Question: What visual encoding does this figure use to show its data?
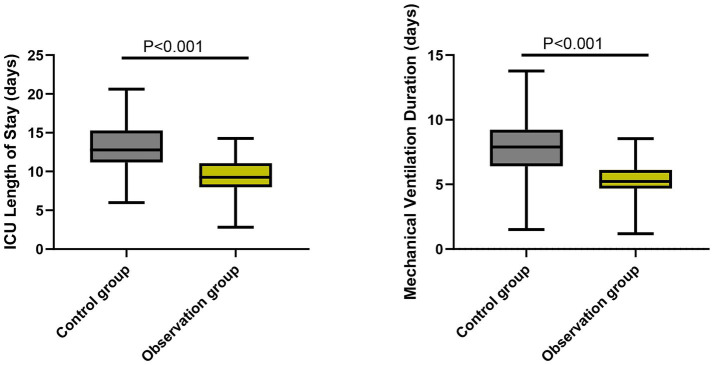
Answer: box